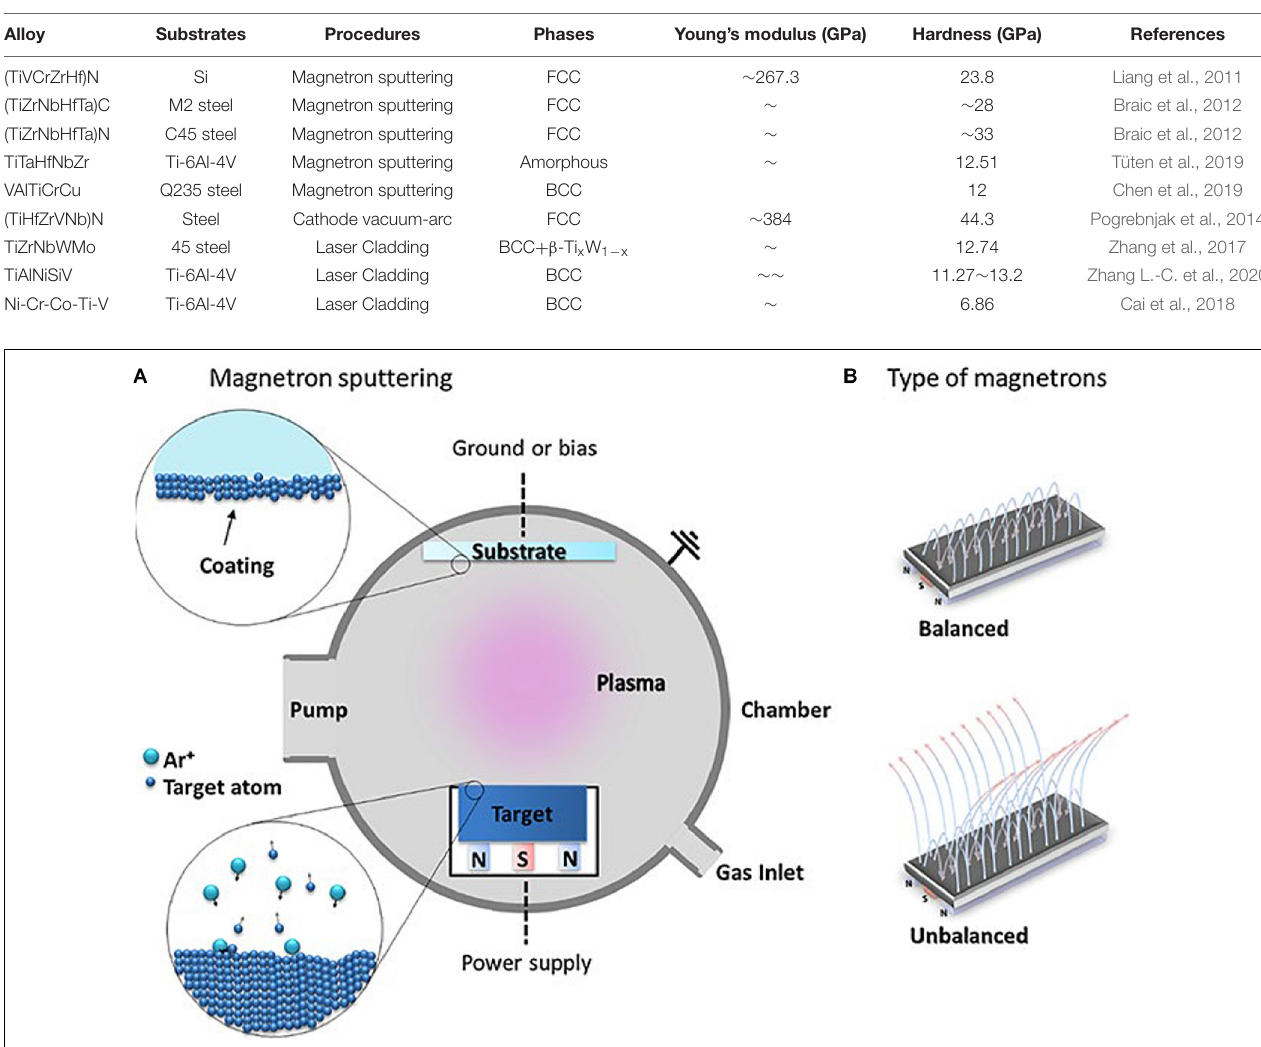
TABLE 3 | Structural features and properties of HEA coatings prepared by laser cladding and magnetron sputtering.